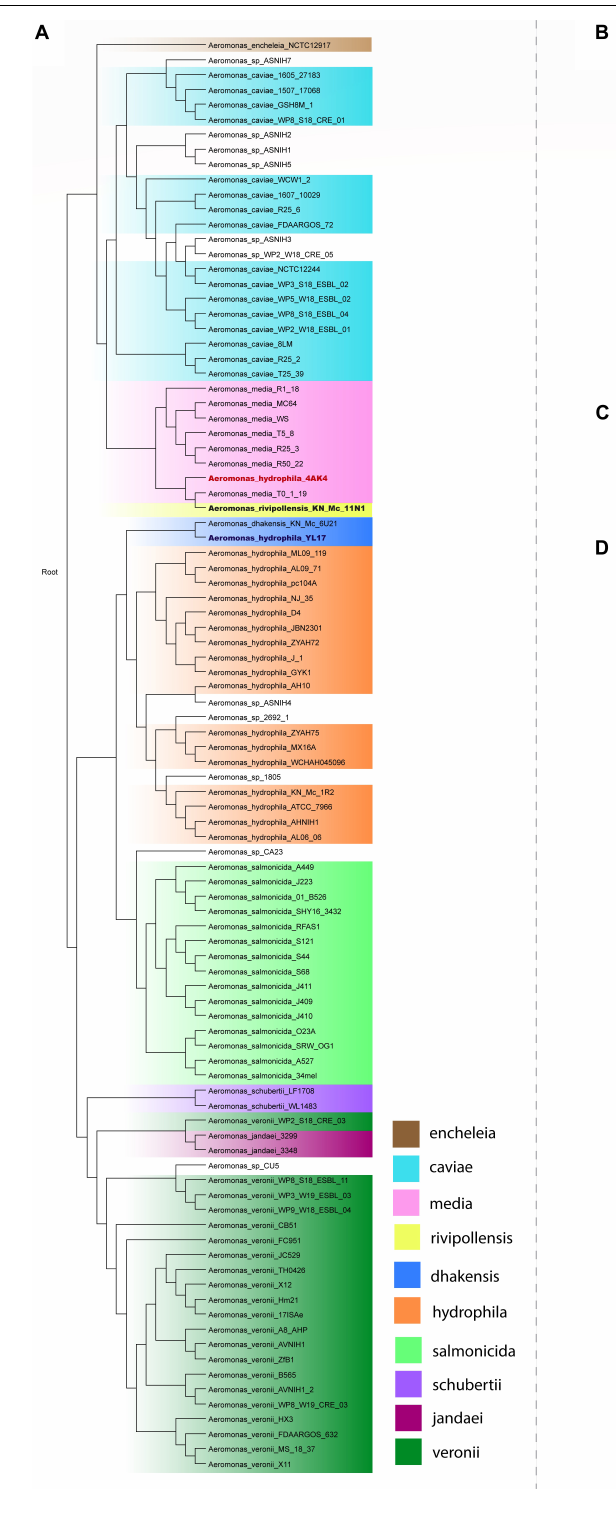
Frontiers in Microbiology |